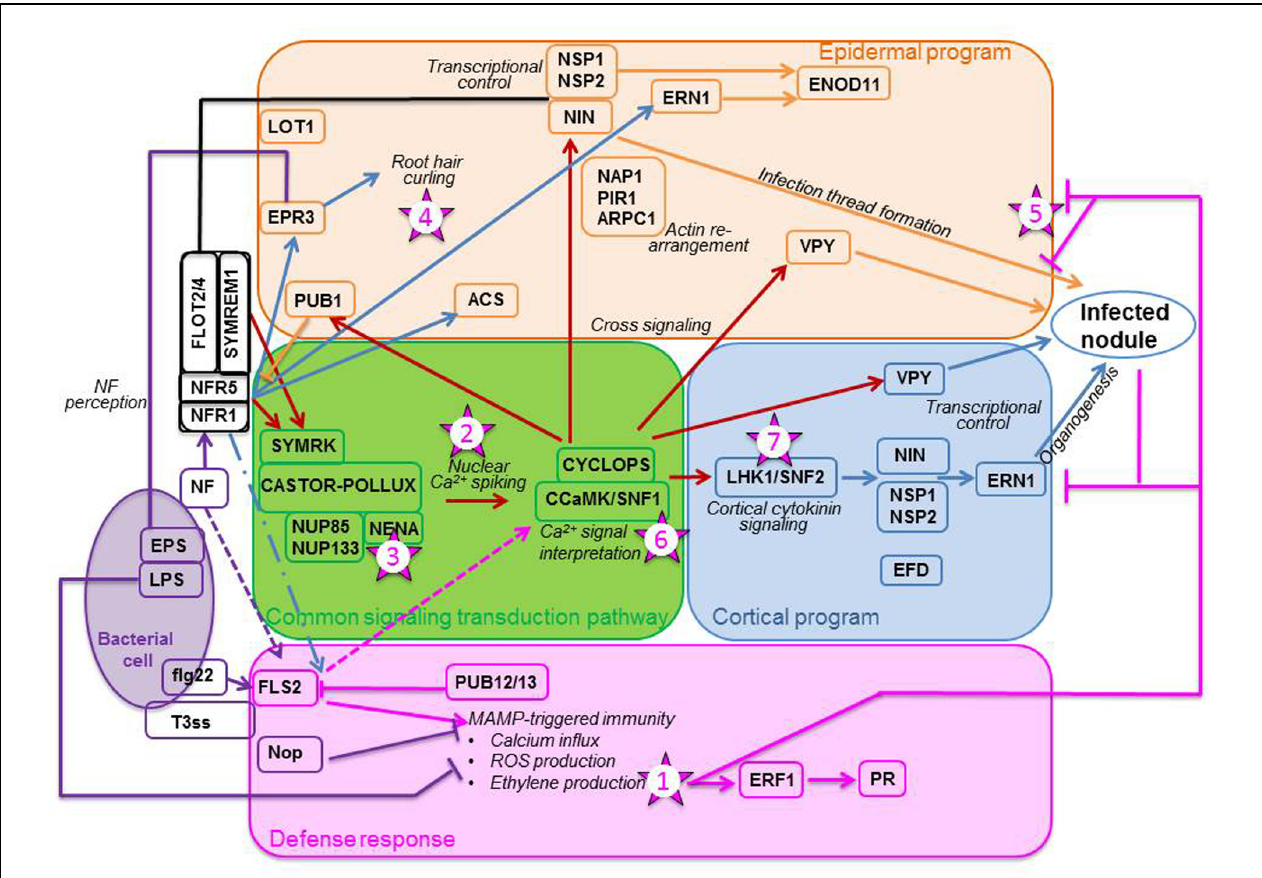
FIGURE 1 | Plant responses to the presence of rhizobia. The bacterium (purple oval) triggers a defense response (pink box) by producing exopolysaccharides (EPS) and lipopolysaccharides (LPS), flagellin-like molecules (flg22), and type III-effector molecules (T3ss) used to inject Nop proteins in the plant cell. As the plant senses these molecules, especially flg22 with the FLS2 receptor, it mounts a set of defense responses. Among the outcomes are the production of ethylene and the up-regulation of pathogenesis-related (PR) proteins. Simultaneously, the rhizobium secretes Nod factors (NFs) which are perceived by the plant receptors NFR1 and NFR5, which may be recruited to membrane micro-domains by remorins (SYMREM1) and flotillins (FLOT2/4). Perception of NFs initiate the CSTP (green box) composed of eight genes: SYMRK, CASTOR/POLLUX, NUP85 and NUP133, NENA, CCaMK and CYCLOPS. CCAMK decrypts the calcium signal, triggering an epidermal program (orange box) and a cortical program (blue box). Epidermal program: Signaling, via CCaMK, triggers the ubiquitin ligase PUB1, considered a negative regulator of NFR1, and the transcription factor NIN which, with NSP1 and NSP2, and the vapyrin (VPY), affects the formation of the infection thread. For this event to occur, proteins important in the layout of the cytoskeleton, such as NAP1, PIR1, and ARPC1, are likely recruited. NF perception may also directly induce transcription of specific genes, such as the EPS receptor EPR3, the ethylene biosynthetic enzyme ACS, and an ethylene response factor required for